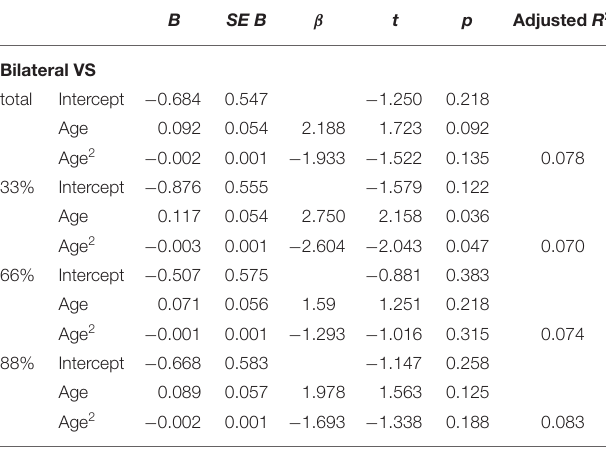
TABLE 4 | Non-linear regressions of the predictor variable (age) on the dependent variable (difference between the monetary and verbal condition) in bilateral VS. B SE B β t p Adjusted R